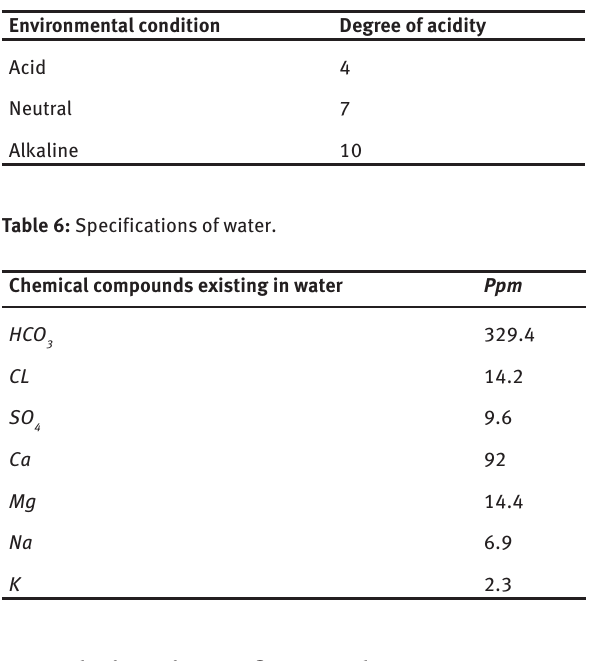
Table 5: The used buffer specification.